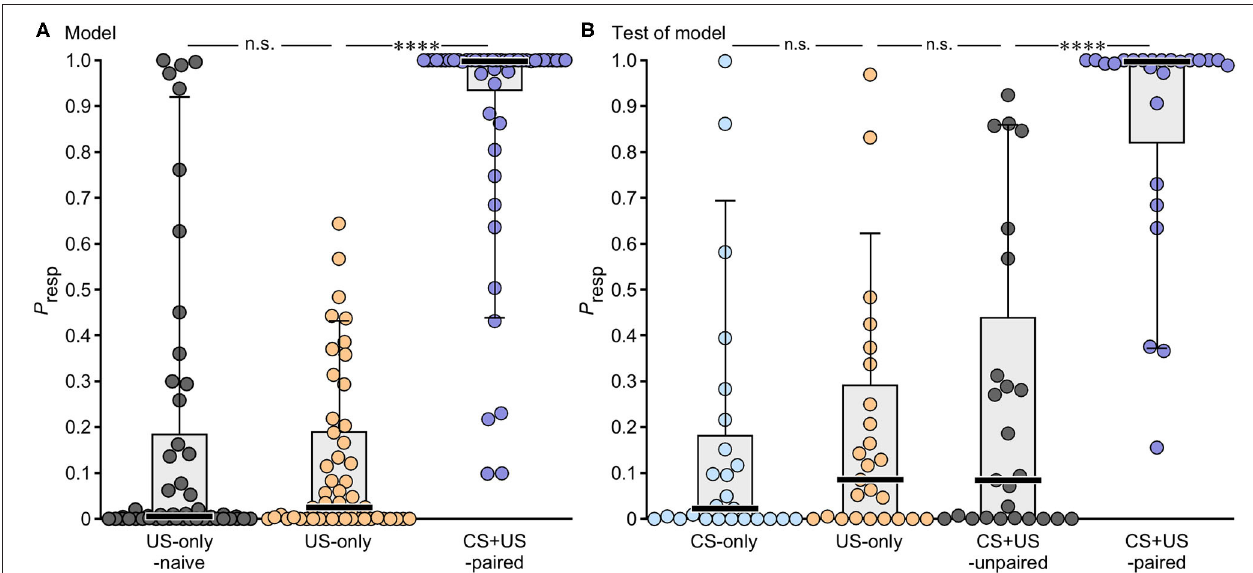
FIGURE 3 | Box plots giving the individual probabilities of showing a conditioned odour response ( P resp ) as derived from binary logistic regression modelling. (A) P resp to odour for animals used to construct the model (US-only, CS + US-paired, N = 50 for each plot), together with data for US-only animals before training when experimentally naive (naive US-only, N = 50). (B) P resp data for animals used to test the model ( N = 25 for each plot). Prior to testing they received either CS-only (blue), US-only (orange), CS + US-unpaired (grey) or CS + US-paired (purple). Circles: individual values; bar: median; box: interquartile range; whiskers: 10th and 90th percentiles. Asterisks indicate significant differences: Wilcoxon signed rank test (naive US-only), Mann-Whitney U -test (all other groups); **** p < 0.0001; n.s., not significant.